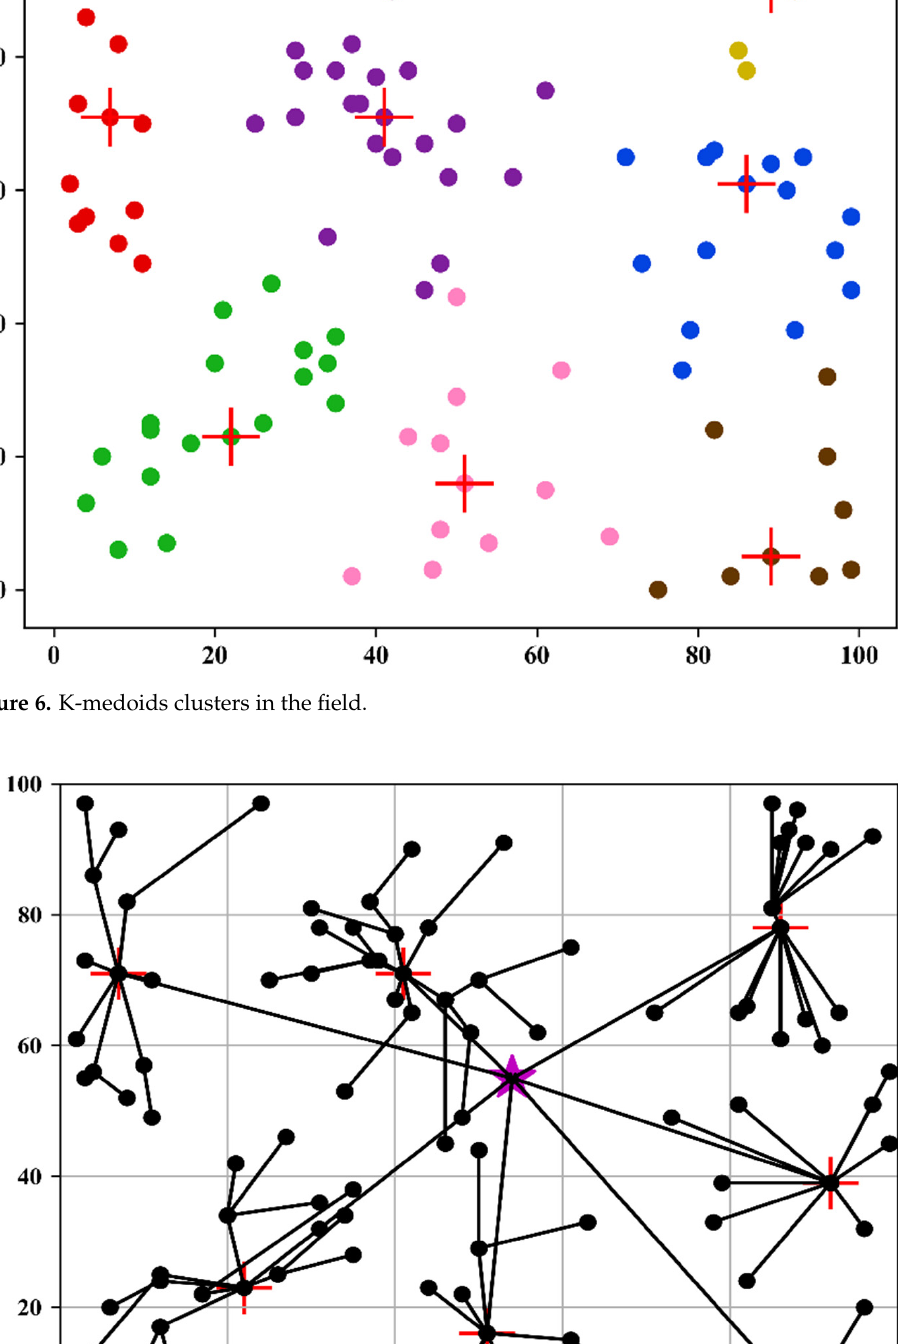
Figure 5. Path constructed with GA [45].